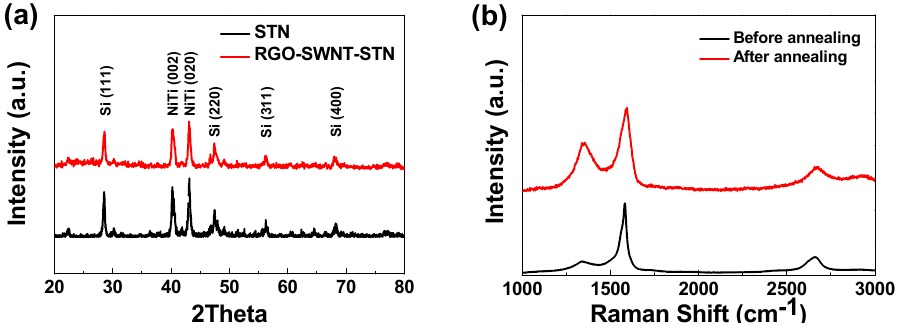
Figure 4. ( a ) X-ray diffraction patterns of Si-Ti-Ni (STN) and rGO-SWNT-STN, ( b ) Raman spectra of freestanding films, before and after